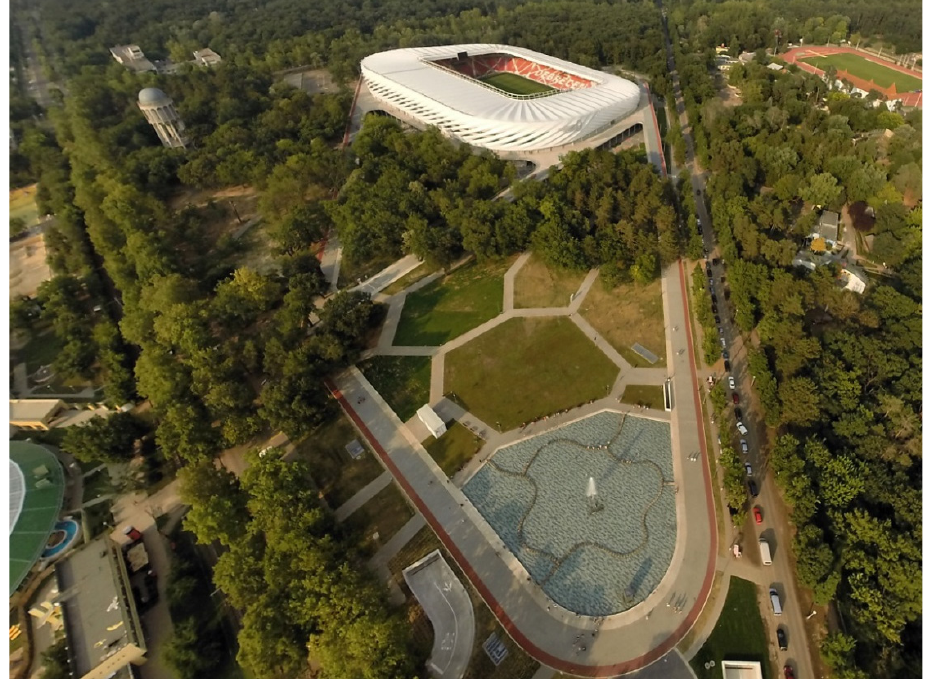
Figure 10. Great Forest Stadium and its vicinity. Source: own work.